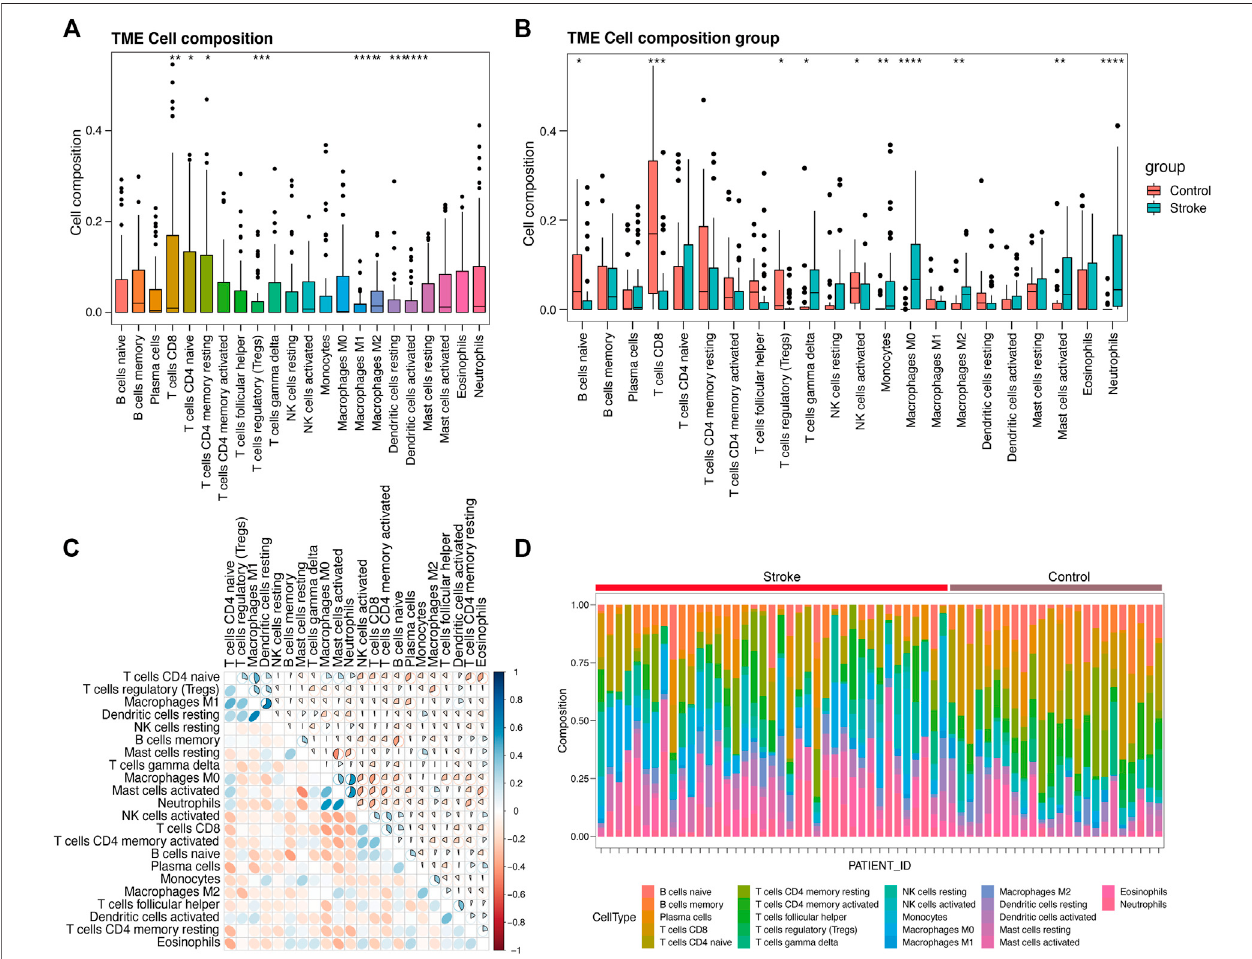
FIGURE 11 | Evaluation and visualization of immune cell in fi ltration. (A) Ungrouped immune cell in fi ltration map. (B) Immune cell in fi ltration map between acute cerebral infarction group and control group. (C) Correlation heat map of 22 types of immune cell in fi ltration. Blue and red indicate positive and negative correlations, respectively. The darker the color, the stronger is the correlation. (D) Immune cell in fi ltration map between a single sample of acute cerebral infarction group and control group. * p < 0.05, ** p < 0.01, *** p < 0.001, **** p <